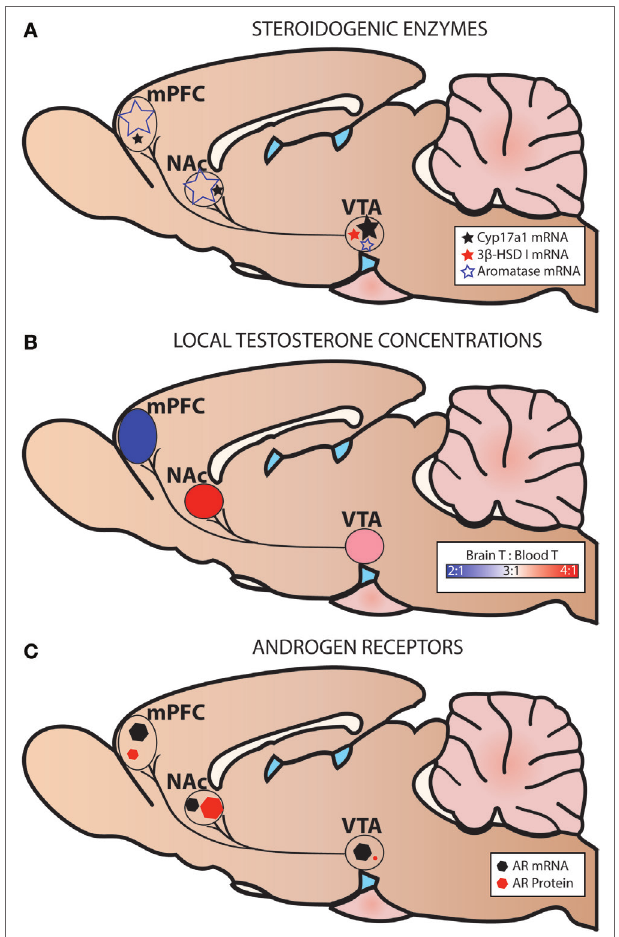
FiGURe 5 | Steroidogenic enzymes, local testosterone concentrations, and androgen receptors (AR) in the mesocorticolimbic system of adult male rats. (A) Levels of steroidogenic enzyme mRNA are based on probe­based quantitative polymerase chain reaction (qPCR) assays (36). (B) Local testosterone (T) concentrations are based on Brain T: Blood T ratios in intact adult male rats [fed ad libitum or calorie restricted (36)]. (C) Levels of AR mRNA are based on probe­based qPCR assays (36), and levels of AR protein are based on immunohistochemistry (33). Levels of AR mRNA and AR protein are not shown relative to one